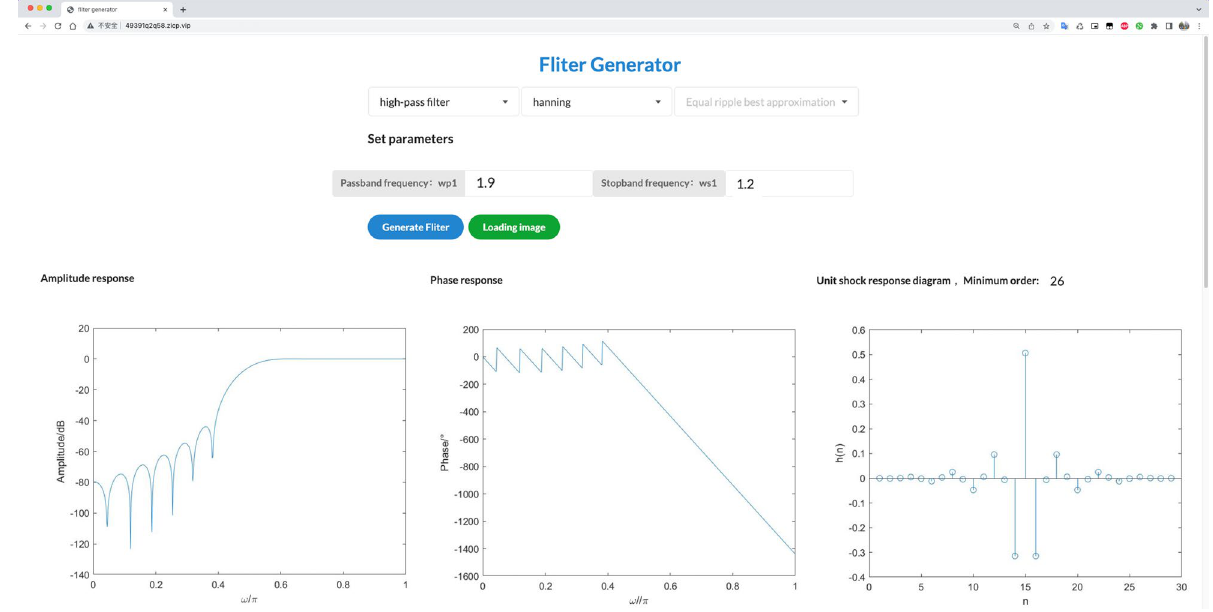
Figure 7. Web-side implementation of the filter